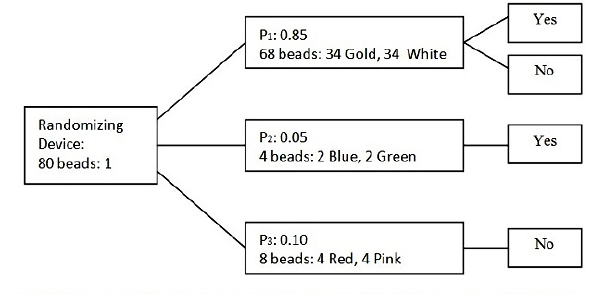
Fig. 1 . Decision tree (adapted from Chaloupka, 1985)